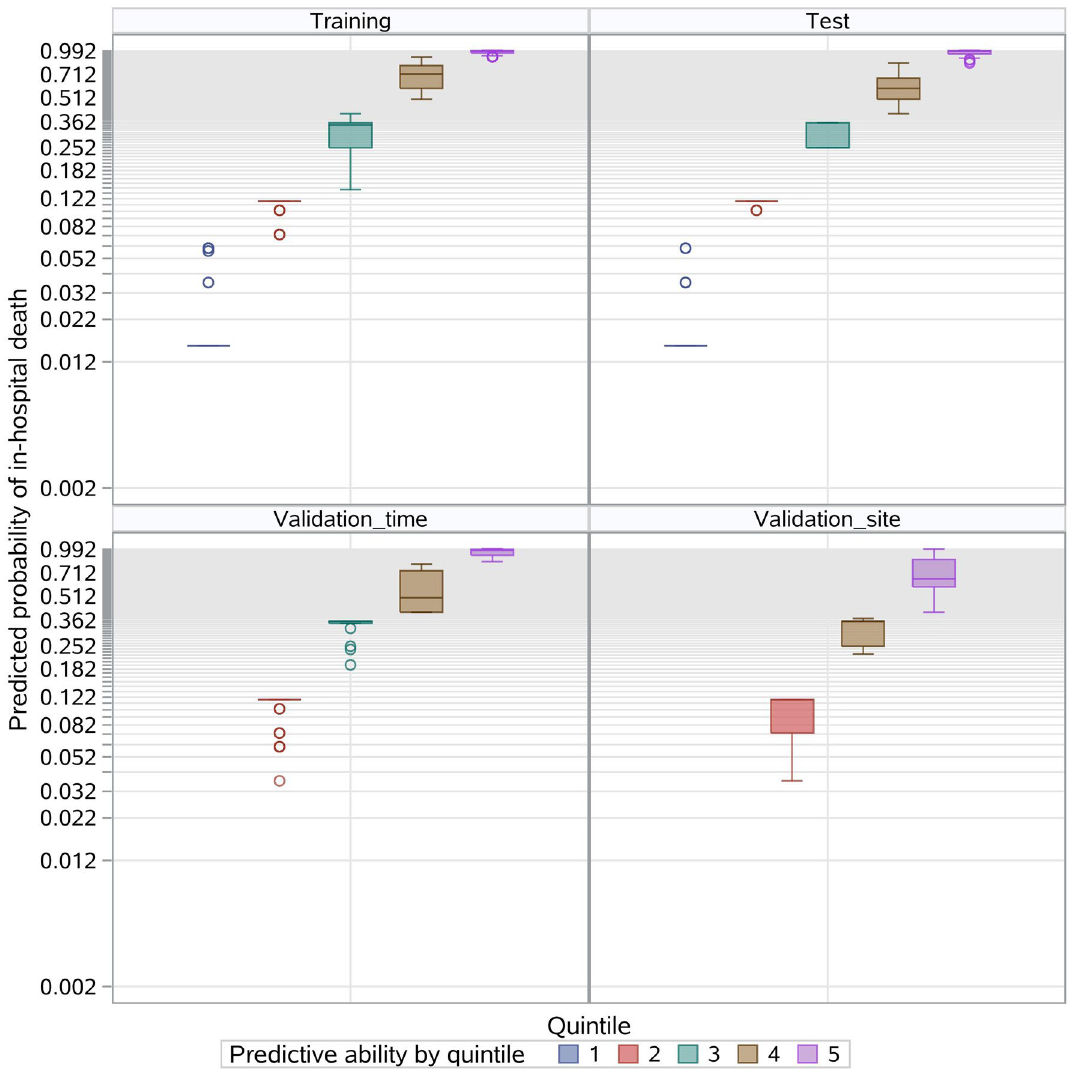
Figure 4. Probability of in-hospital death events by quintiles in the training, test, and validation_time and validation_site samples. Patients in each sample were divided into five classes based on the combination of eight risk